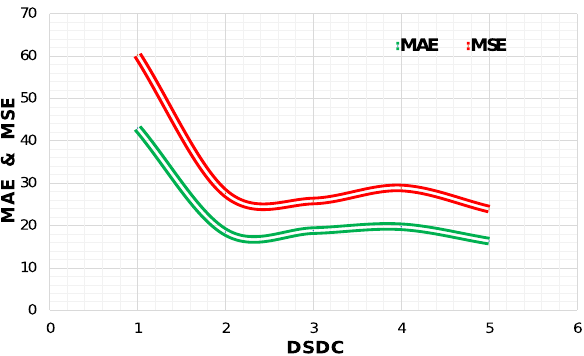
Figure 5. A comparison between counting accuracy (MAE, MSE) and increasing number of